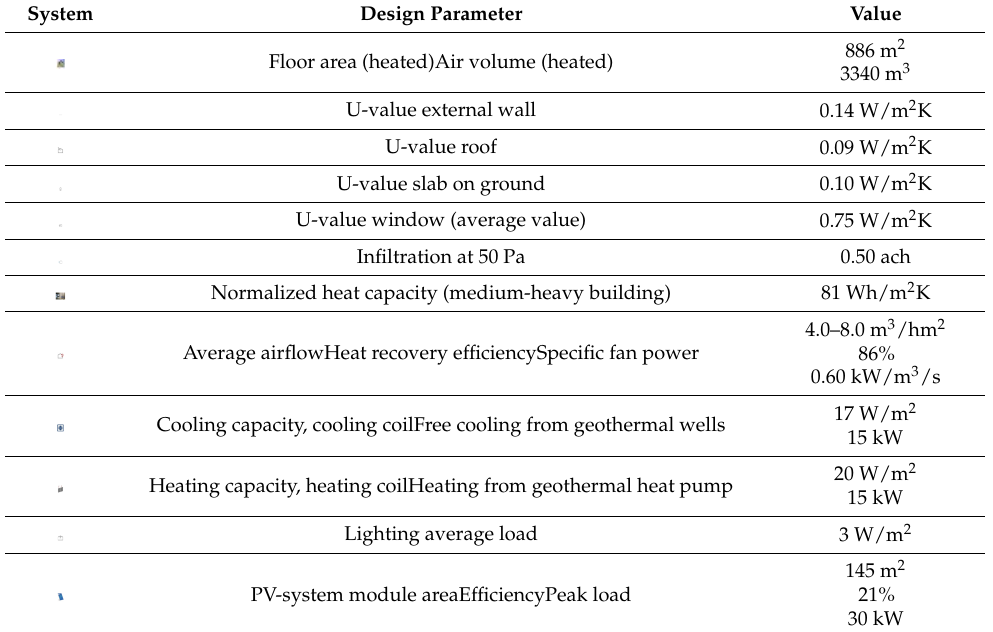
Figure 2. Drøbak Montessori lower secondary school. (Credit: Robin Hyes, Skanska). Table 1. Design details of the Powerhouse Drøbak Montessori lower secondary